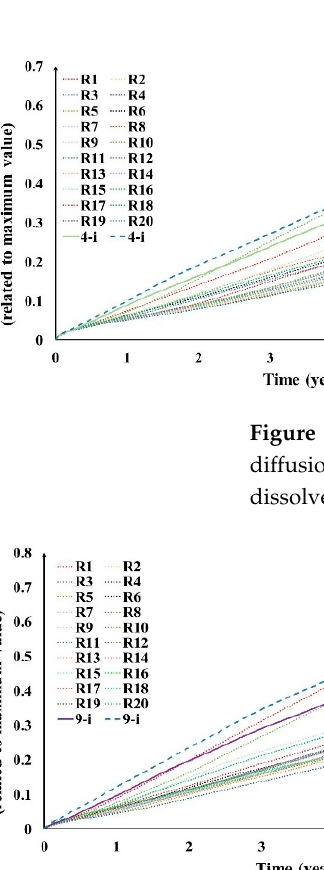
Figure 9. The heterogeneous realizations (dotted lines), homogeneous with considering cross-diffu-